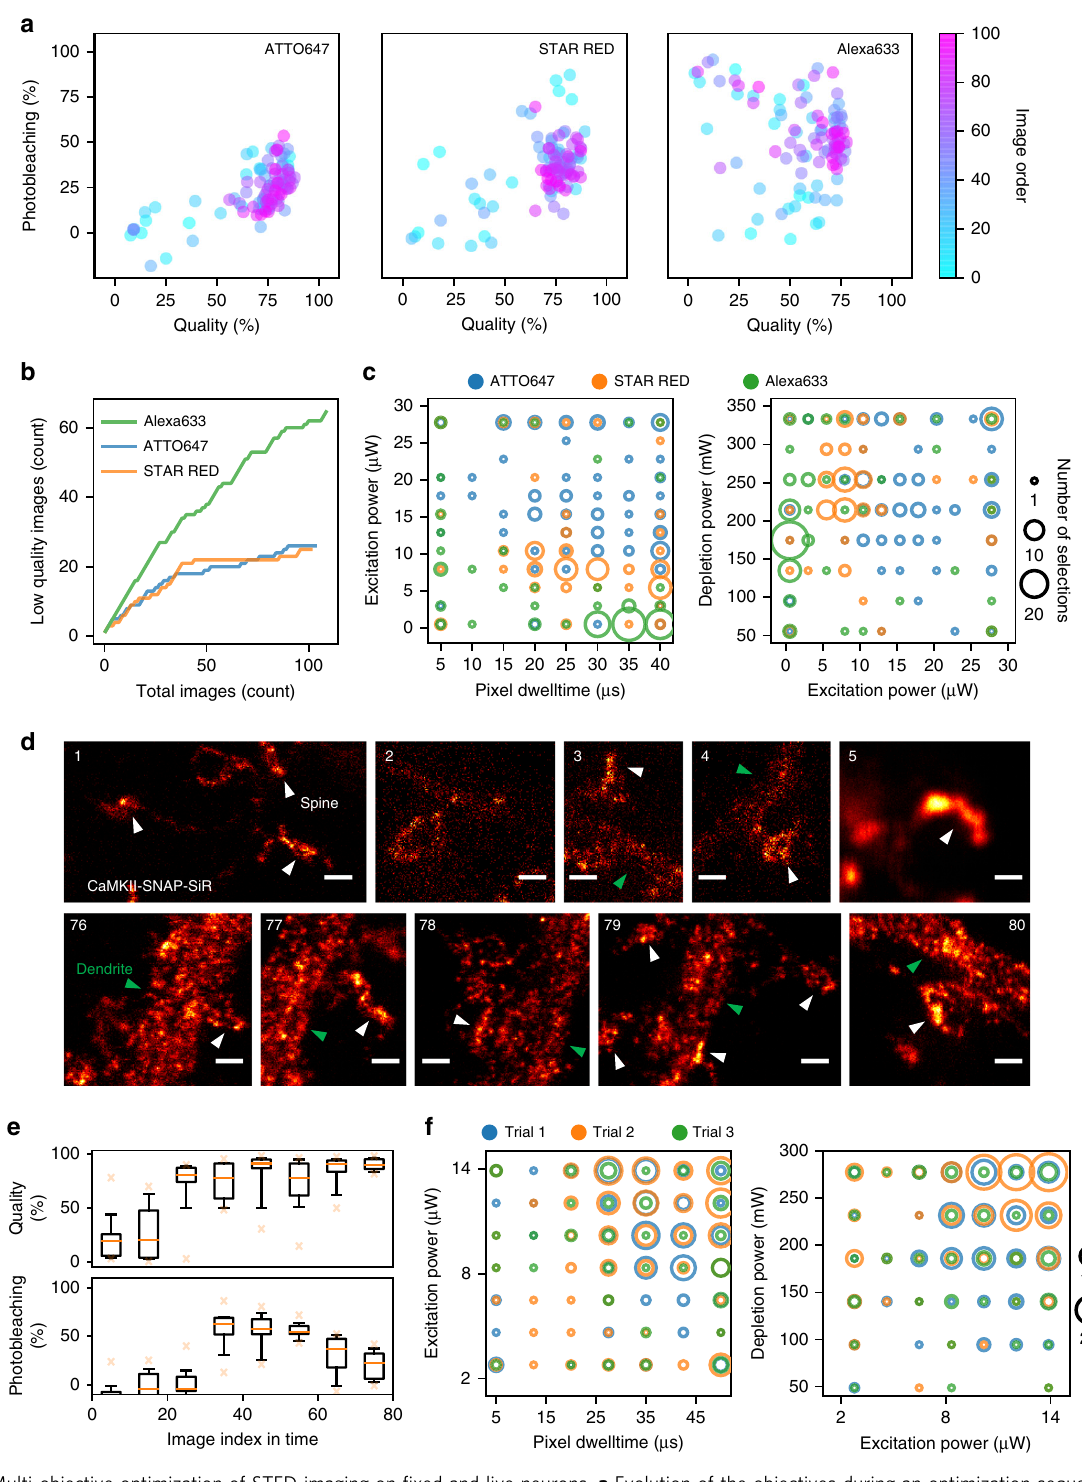
Fig. 2 Multi-objective optimization of STED imaging on fi xed and live neurons. a Evolution of the objectives during an optimization sequence, from fi rst (cyan) to 100th image (pink), for the protein α -tubulin marked with ATTO647, STAR RED, and Alexa633. b Cumulative regret (related to the quantity of low-quality images, i.e. below 70%) obtained during the Kernel TS optimization sequences shown in a . c Parameter con fi gurations selected by Kernel TS for fl uorophores shown in a . d Example images of α CaMKII tagged with SNAP-SiR of the fi rst fi ve (1 – 5) and last fi ve (76 – 80) images taken during one live- cell optimization trial. White and green arrowheads highlight the position of dendritic spines and shafts respectively. Scale bars 500 nm. e Distribution of image quality and photobleaching for one optimization sequence of α CaMKII-SNAP-SiR (Trial 2 in panel f ). One bin corresponding to the average of ten images. Orange line indicates the median, box covers the fi rst to the third quartiles, and whiskers extend from 10th to 90th percentiles. f Parameter con fi gurations selected by Kernel TS during different live-cell imaging trials. In c and f the size of the circles scales with the number of images that were acquired with a given con fi guration. Shown are two planes of the three-dimensional parameter space. Quality scores from 0 to 1 are expressed